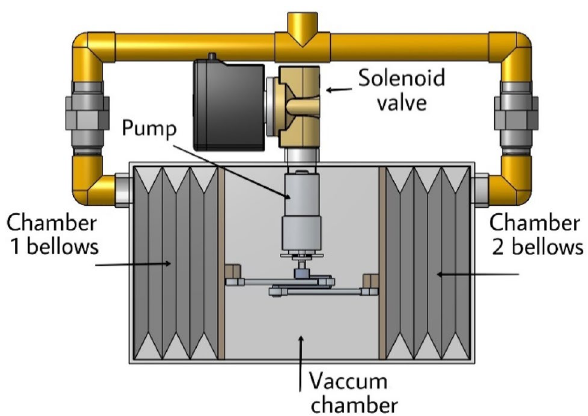
Fig. 9 An insight into the bellows pump with its functional